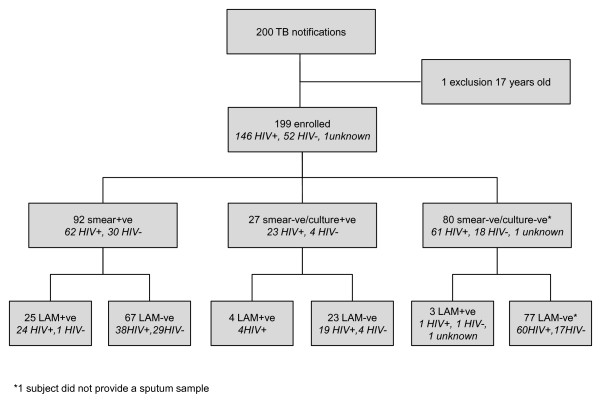
LAM Study Consort Diagram. Disposition by HIV and TB sputum bacteriological status of 200 consecutive patients presenting to a South African township TB clinic and undergoing LAM-ELISA urine testing